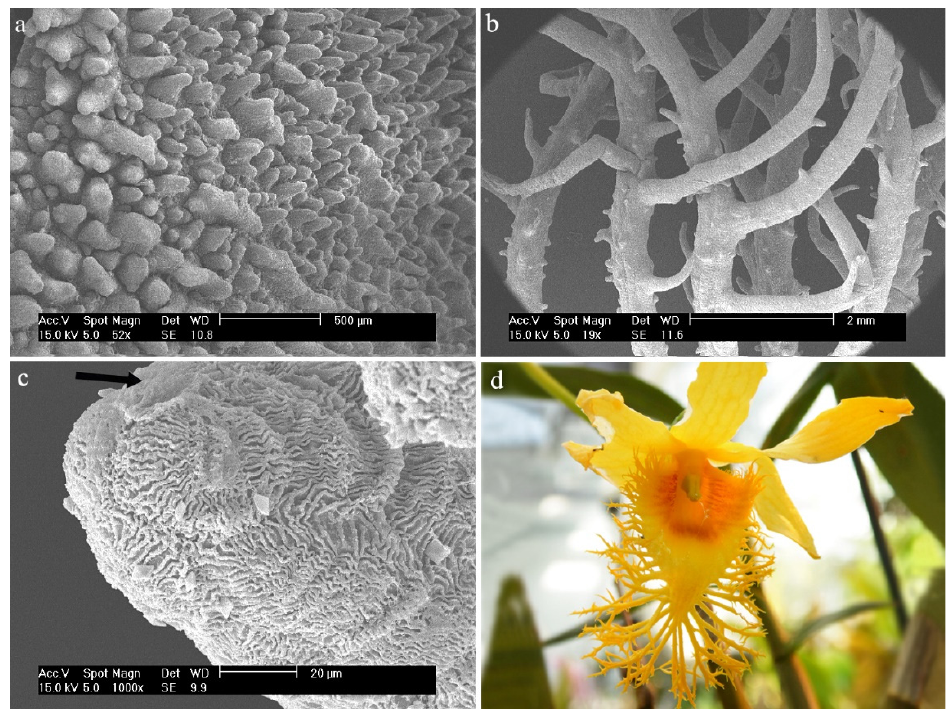
Figure 7. Dendrobium brymerianum Rchb.f.: trichomes ( a ) of the mesochile part of the labellum; ( b ) of the margin of the mesochile part of the labellum; ( c ) of the epichile part of the labellum; ( d ) flower (photo by Monika Lipi ń ska).